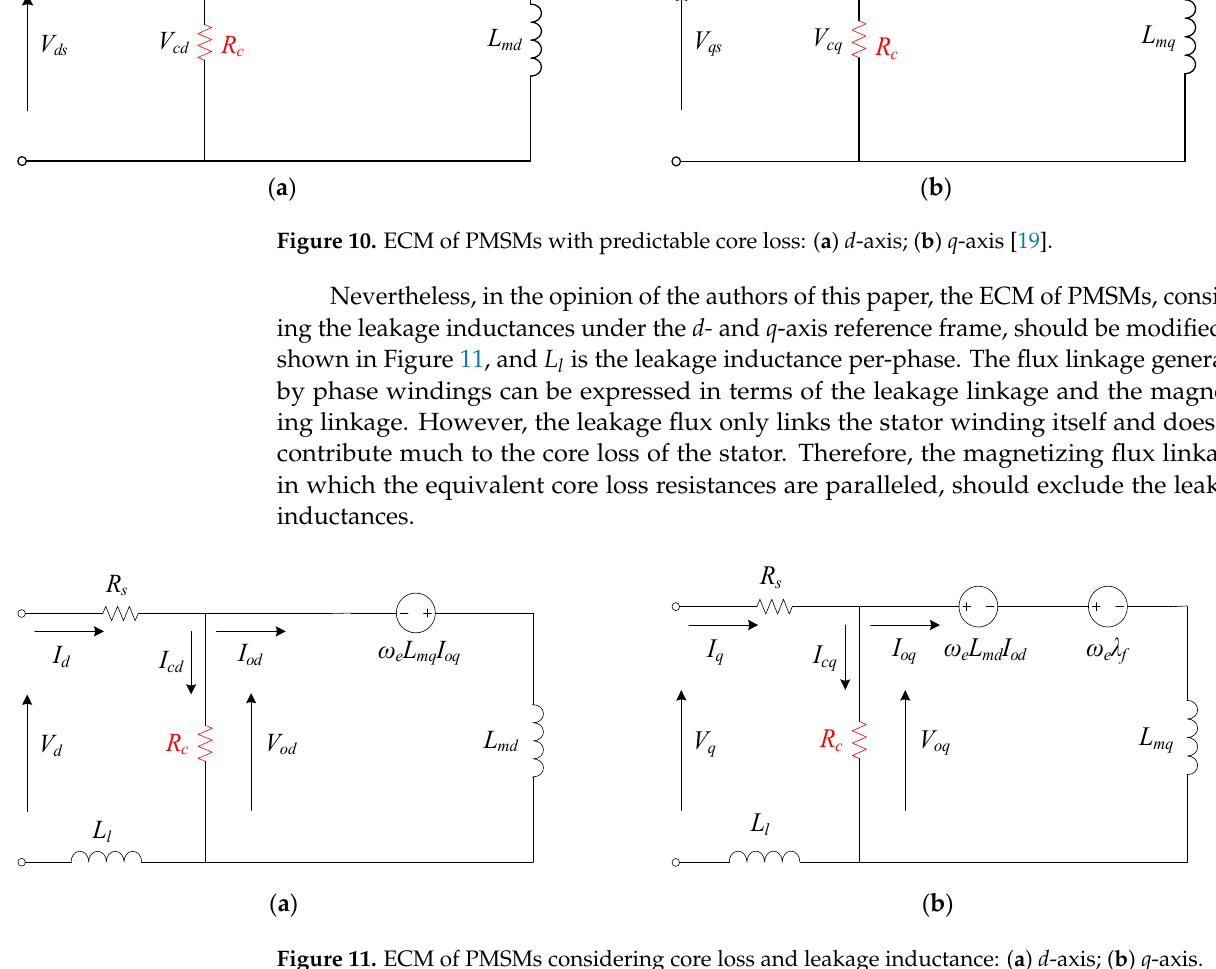
Figure 11. ECM of PMSMs considering core loss and leakage inductance: ( a ) d -axis; ( b ) q -axis. After the reference frame transformation, the three-phase sinusoidal currents under the abc reference frame can be recognized as direct currents under the d -and q -axis reference frame. Therefore, based on the concept of the direct currents, the voltages across the d -and q -axis inductances would be zero in the steady state, resulting in the elimination of the d -and q -axis inductances in the equivalent circuit model of PMSMs [21–27], as shown in Figure 12 [25]. For the determination of the equivalent core loss resistance R c , although the value of R c changes with the operating conditions, [22,25] calculated it from the results of tests performed at nominal voltage and synchronous speed, i.e., R c is assumed to be a constant in that condition.